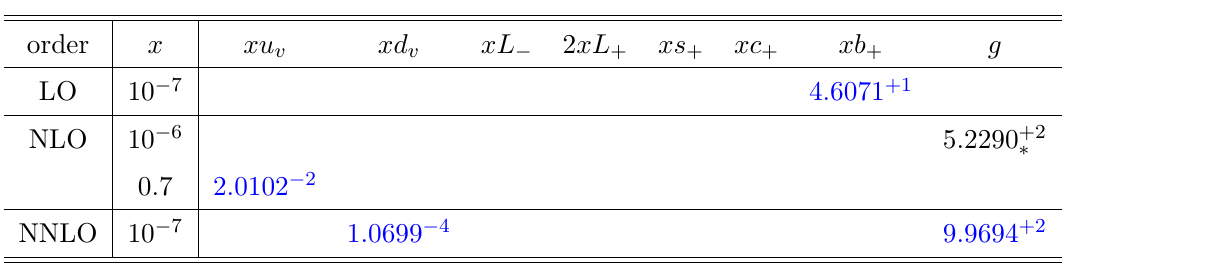
Table 3 As Table 2, but for evolution and flavor matching from n F = 3 ... 5. The corresponding benchmark tables are in Ref. [73] for LO and NLO and in Ref. [74] for